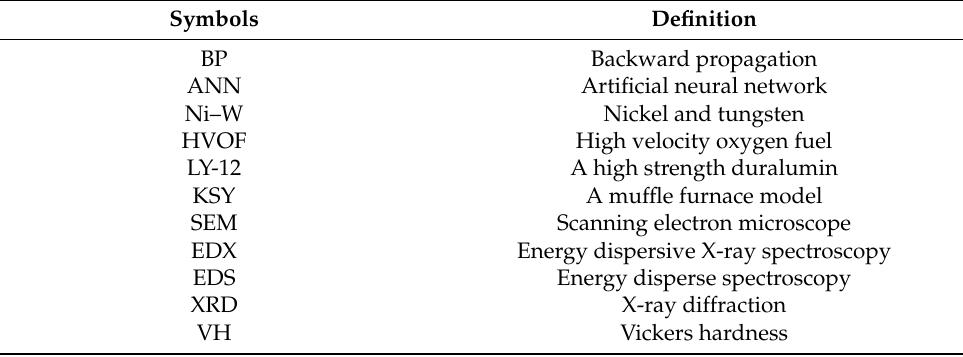
Table A2. Abbreviations in